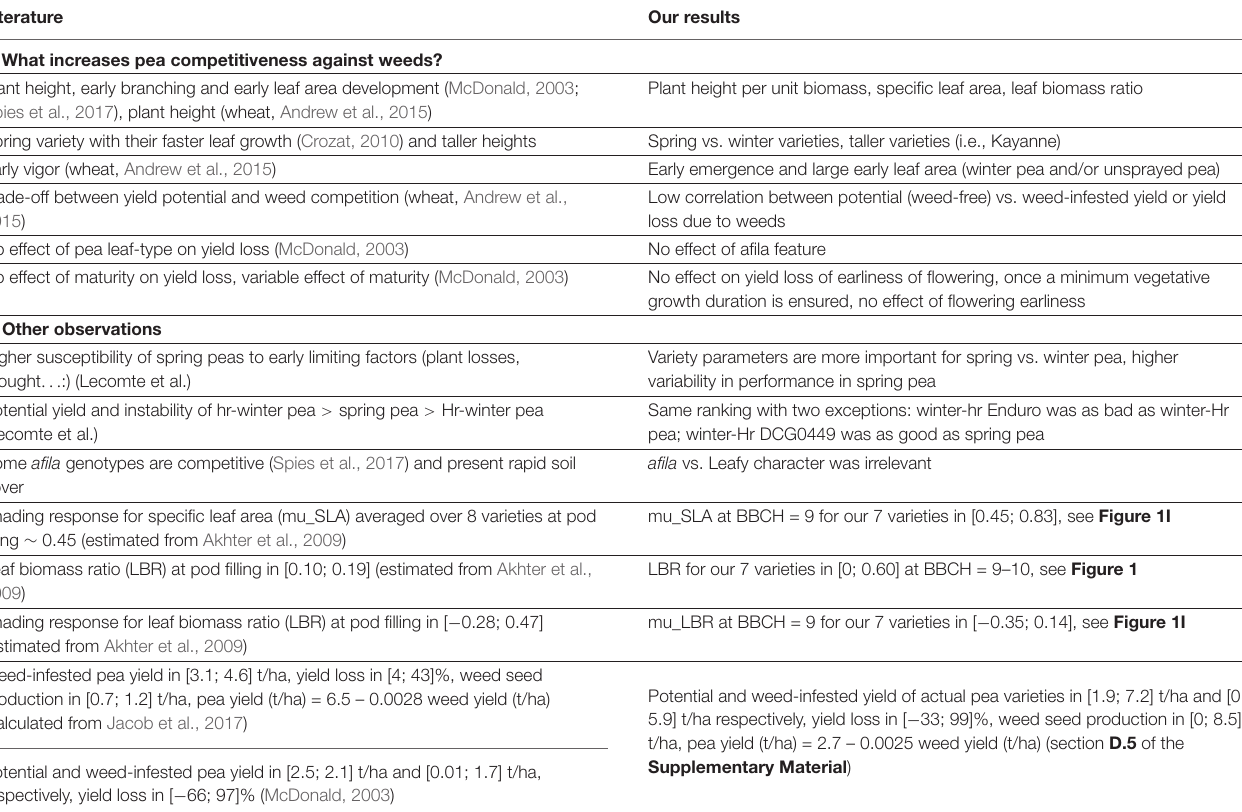
TABLE 6 | Consistency of present results compared to literature